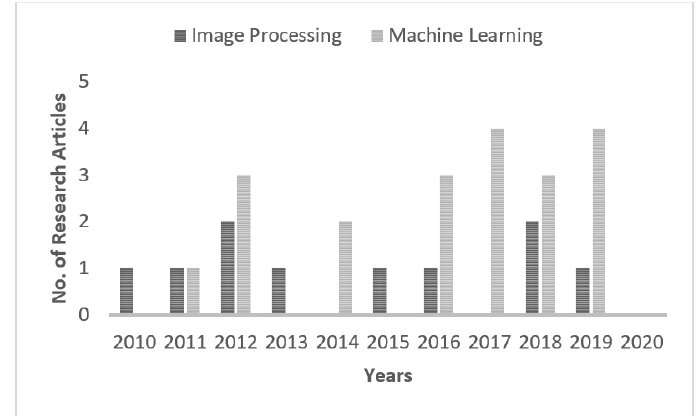
Figure 5. Year-wise Distribution of Articles.